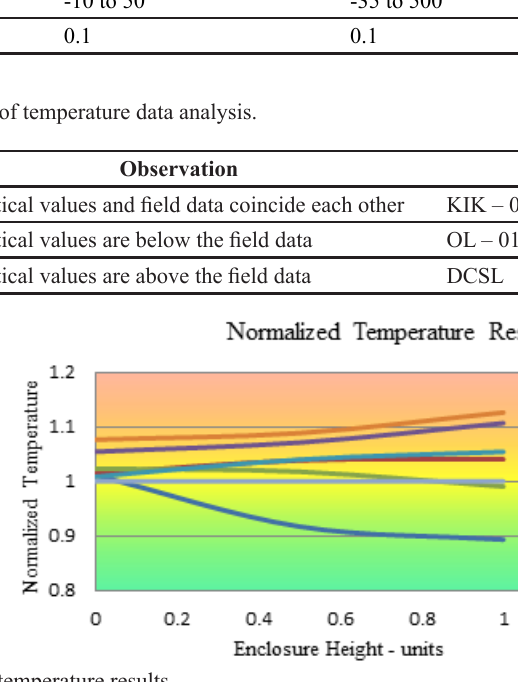
Figure 3: Normalized temperature